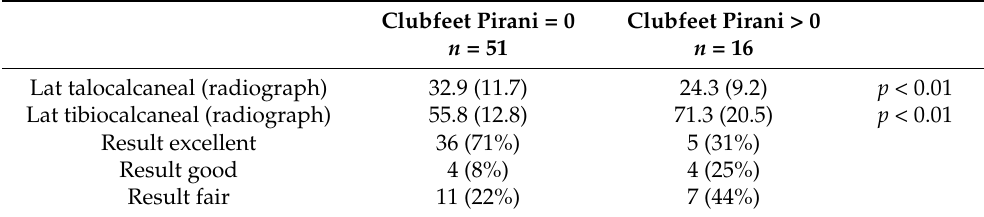
Table 4. Comparison between patients with fully corrected clubfeet at the age of three months (Pirani = 0) and not fully corrected clubfeet (Pirani >